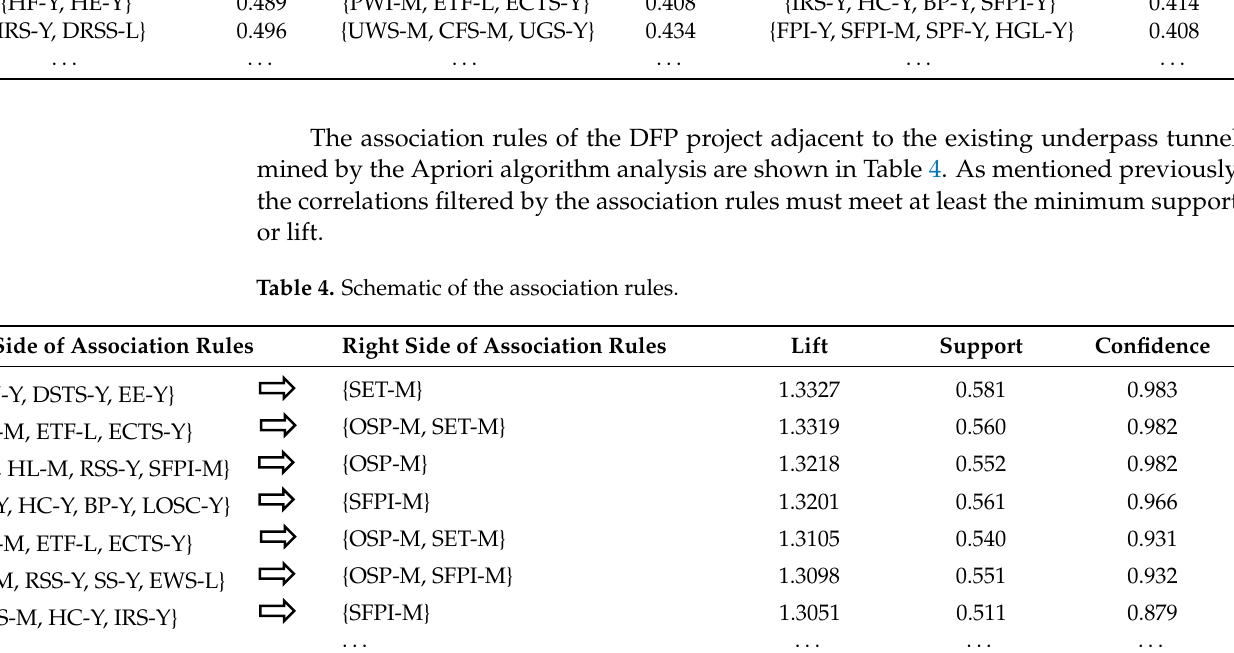
Table 3. Frequent item set of construction risks of DFPs in adjacent existing underpass tunnels.